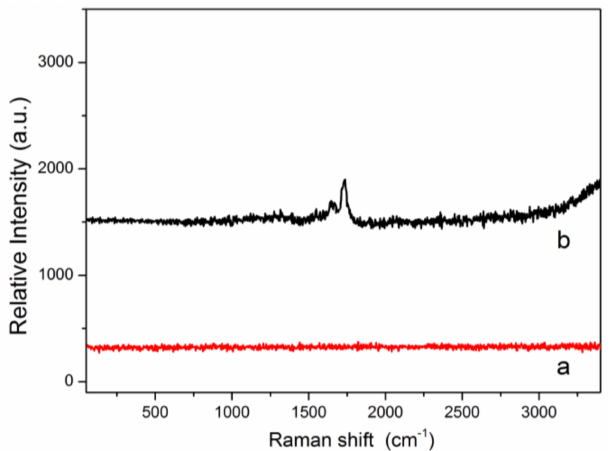
Figure 4. Raman spectra of the stainless steel wire mesh ( a ) and the MPS functionalized stainless steel wire mesh ( b ).